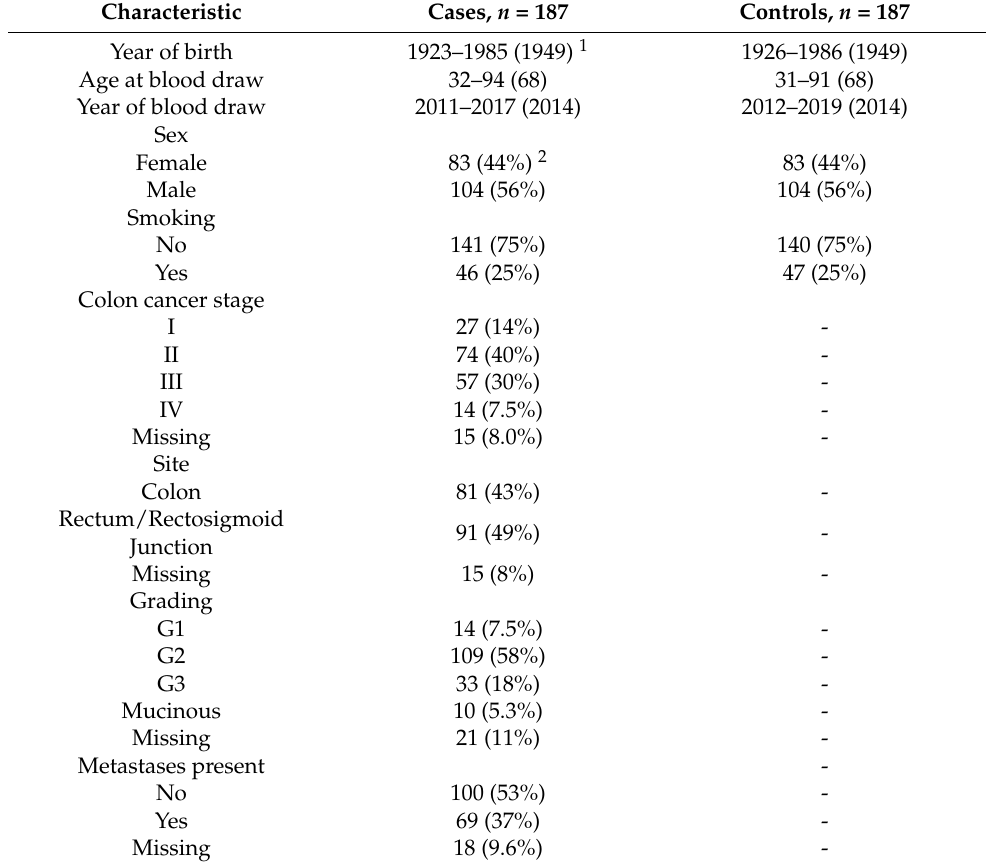
Table 1. Characteristics of individuals enrolled into the